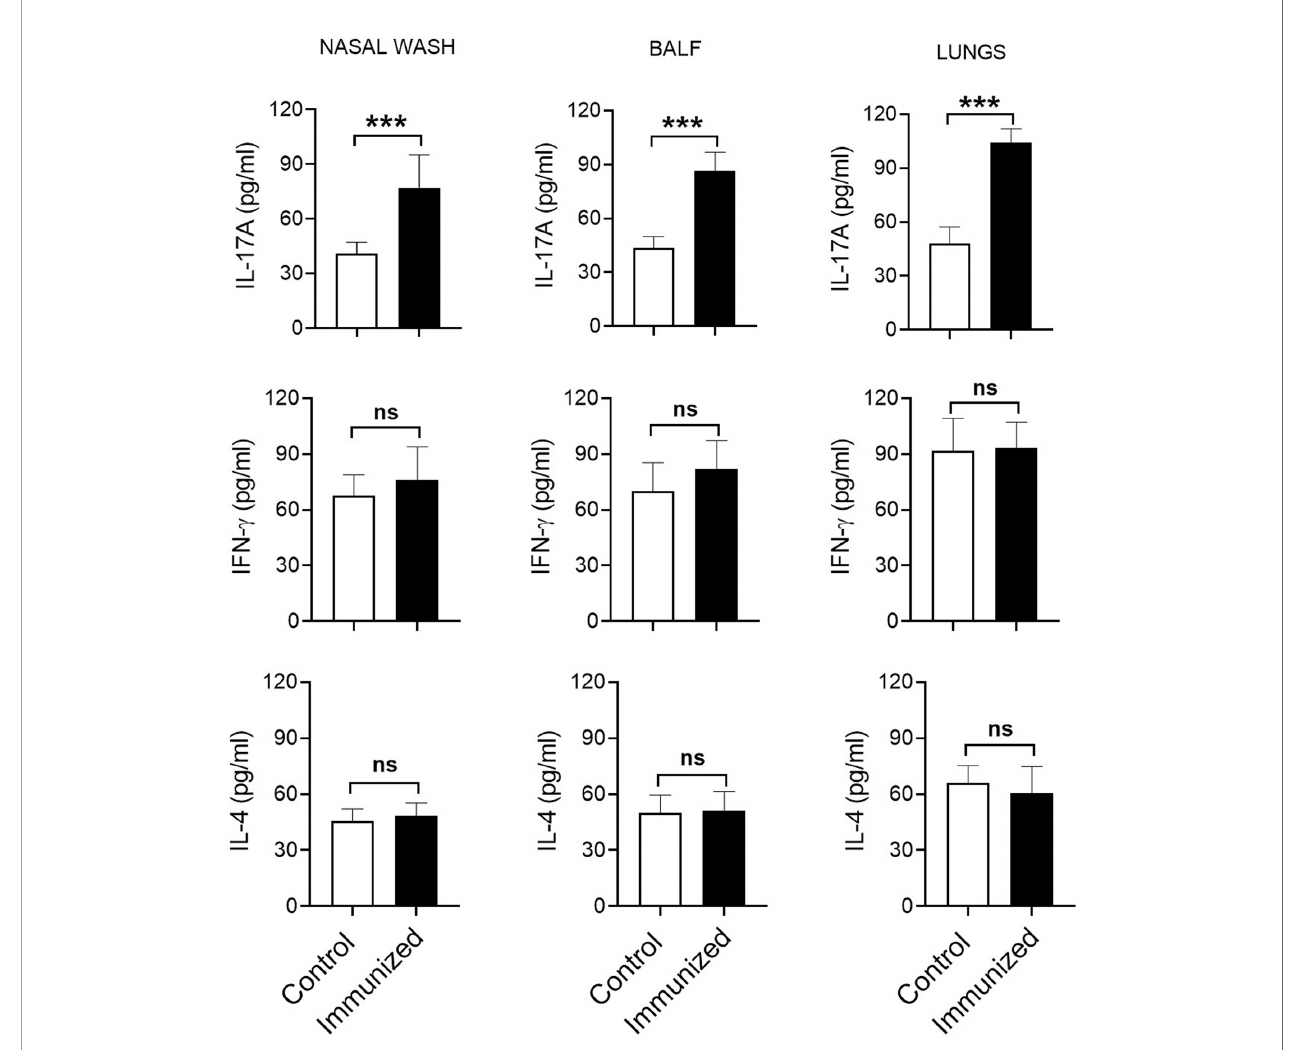
FIGURE 3 | Cytokine responses in the respiratory tract after immunization. Nasal wash, BALF, and lungs were collected from the immunized mice subjected to pneumococcal challenge infection, and the cytokine levels were measured using ELISA. Data are shown as mean ± SD and pooled from the results of two independent experiments with 4 mice in each group. ***p<0.001. Unpaired student ’ s t test. ns, not signi fi